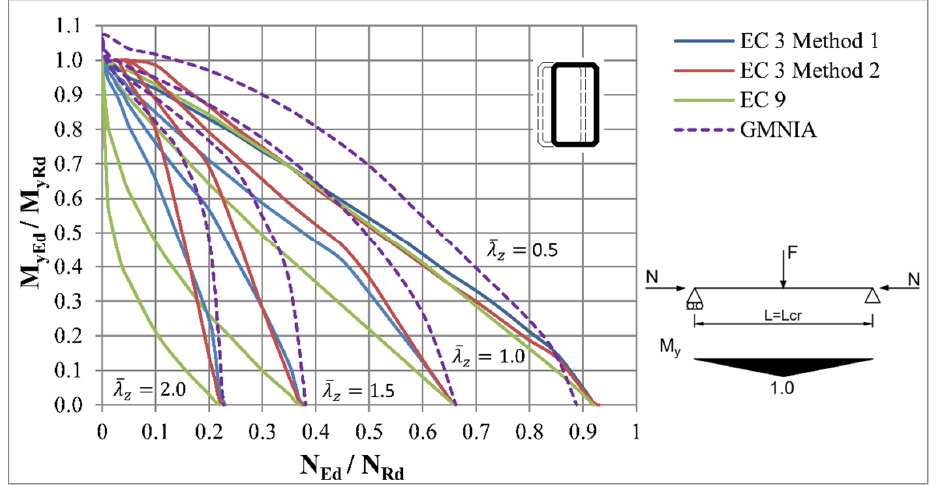
Figure 40. Interaction curves for beam-columns with RHS cross-section without lateral restraints.